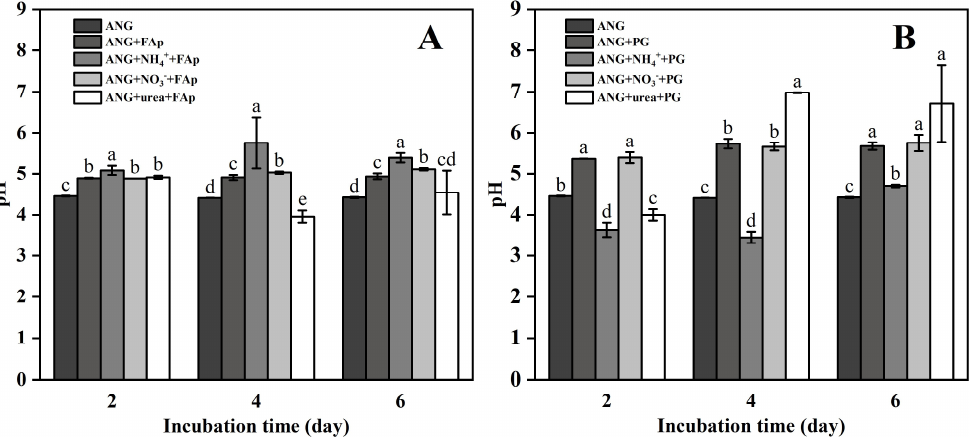
Figure 2. The pH value in adding the FAp ( A ) and PG ( B ) treatments during the incubation (2, 4, and 6 days). The error bars represent the standard deviations of three replicates. The different lower-case letters indicate a significant difference between the treatments ( p < 0.05). The significant differences among the treatments were identified by Tukey test ( p < 0.05) via one-way ANOVA.